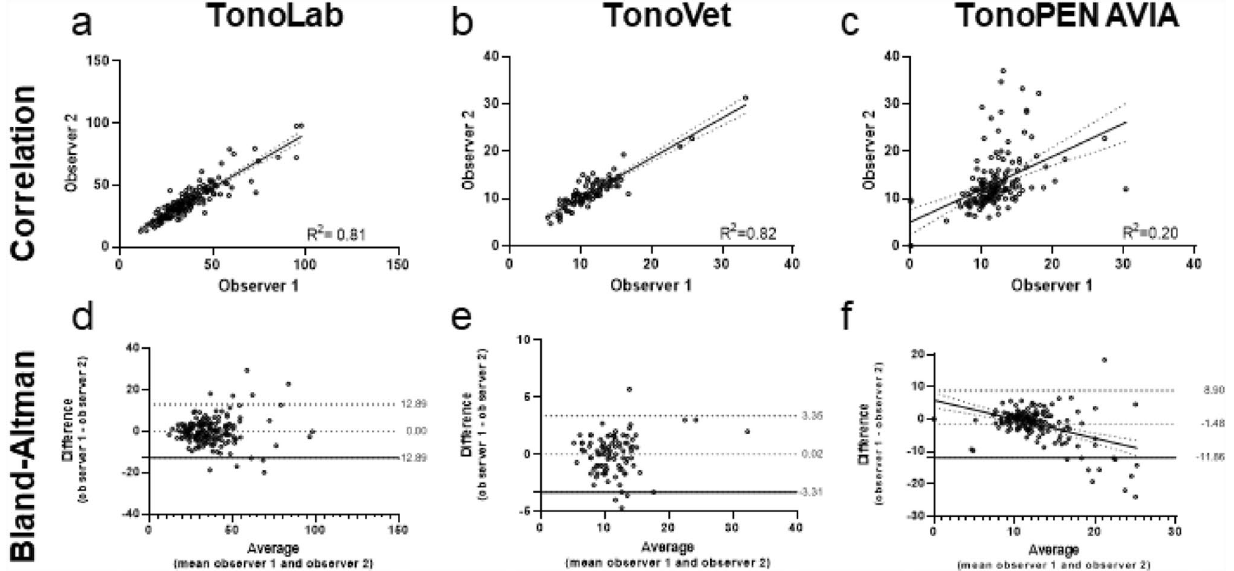
Figure 4. Reproducibility of different tonometers. ( a – c ) Show scatter plots with linear regressions (dashed lines is the 95% confidence interval (CI)). ( d – f ) Show a Bland and Altman plot expressing the difference of measurements by the observers plotted over the mean of the observers.